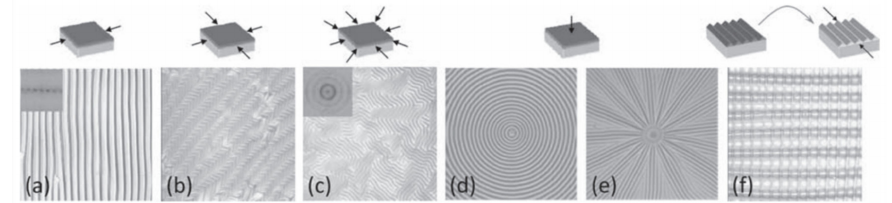
Figure 2. Optical images of various morphological patterns demonstrate that the wrinkling patterns prefer to orient themselves perpendicular to the axis of principal compressive stress: ( a ) stripes (uniaxial mechanical compression), ( b ) herringbones (biaxial mechanical compression), ( c ) labyrinths (isotropic thermal contraction), ( d ) circular, ( e ) radial, and ( f ) checkerboards (uniaxial mechanical compression on a pre-patterned substrate). Reproduced with permission from ref. [37]. Copyright 2011, John Wiley & Sons,